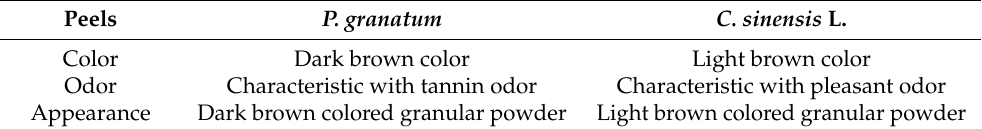
Table 2. Physical observation of P. granatum and C. sinensis L. peel